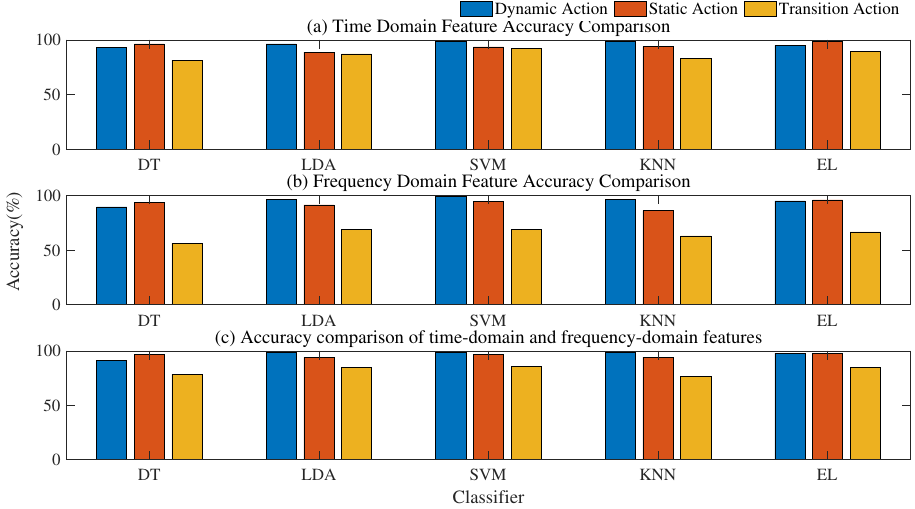
Figure 6. Accuracy comparison of the same features on different classifiers.